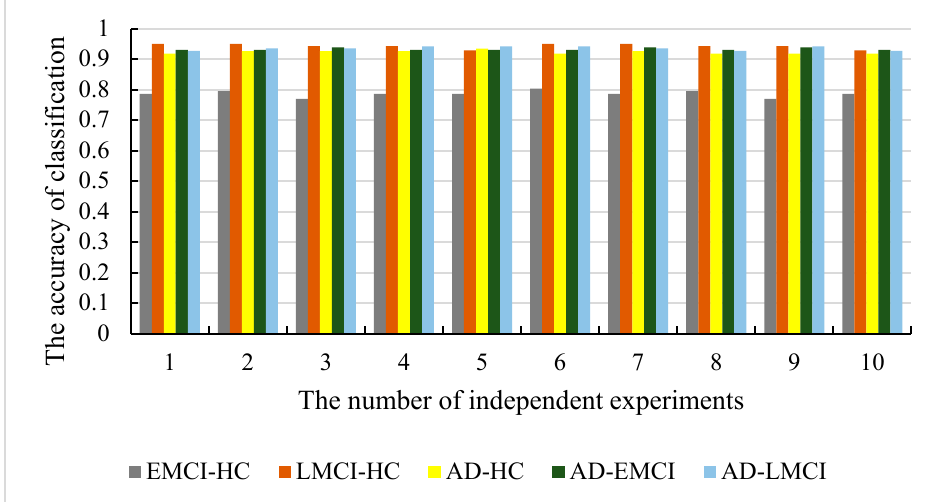
Figure 9. The classification accuracy of our models in five datasets.